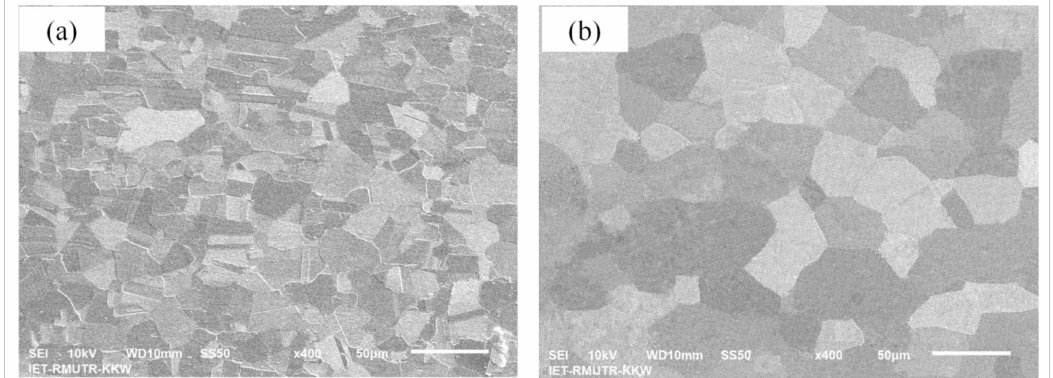
Figure 12. SEM images of the base metals: ( a ) SUS316L; ( b ) SUS425.